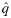
Profiles of oxygen partial pressure and oxygen transfer rate.(A) Temporal change in the distribution of the oxygen partial pressure for k = 0.9. (B) Profiles of the oxygen partial pressure for various diameter reduction ratios (k = 0.7, 0.9, and 1.1). (C) The dependence of the oxygen transfer to the blood capillaries on the airway depth. Note that the area below the curves is equal to unity by the definition of q^.